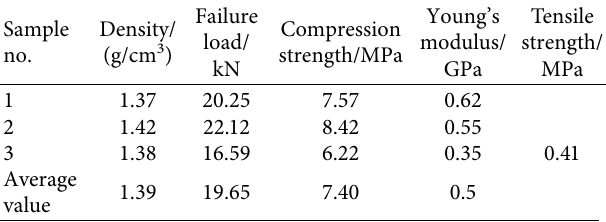
Table 1: Results of the uniaxial compressive strength test in coal. Sample